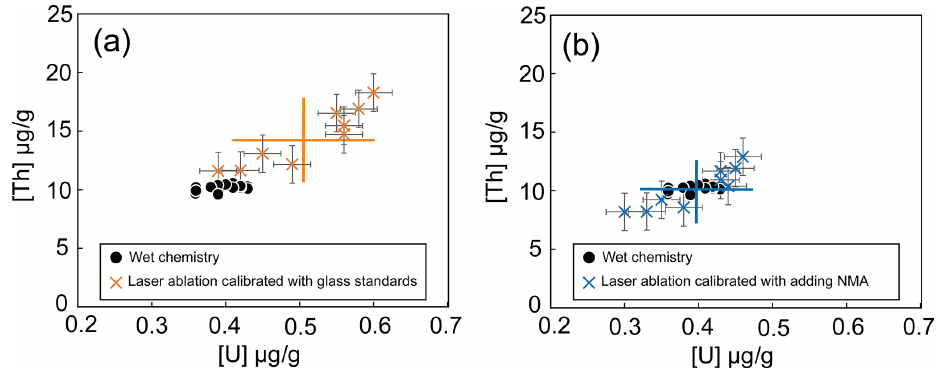
Figure 7. Comparison between results obtained by LA-ICP-MS for the two calibrations and by wet chemistry for the RB magnetite sample. (a) Calibration with silicate glasses as mean value and dispersion reported with the orange crosses; (b) calibration with addition of NMA sample with mean value and associated dispersion (blue crosses). U and Th contents obtained using wet chemistry protocol are represented by the black